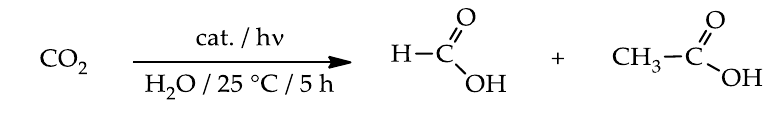
Scheme 2: Photoreduction of carbon dioxide.